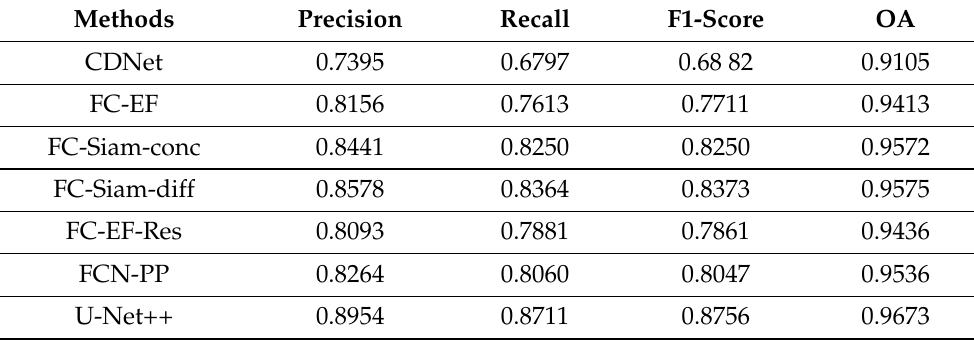
Table 15. Quantitative results for VHR images [157].